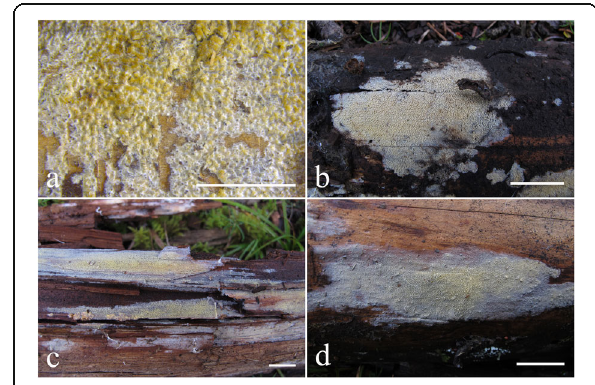
Fig. 10 Basidiomes of Skvortzovia qilianensis . a b LWZ 20180904-16 (holotype). c LWZ 20180904-18 (paratype). d LWZ 20180904-20 (paratype). Scale bars: a = 5 mm, b – d = 2 cm